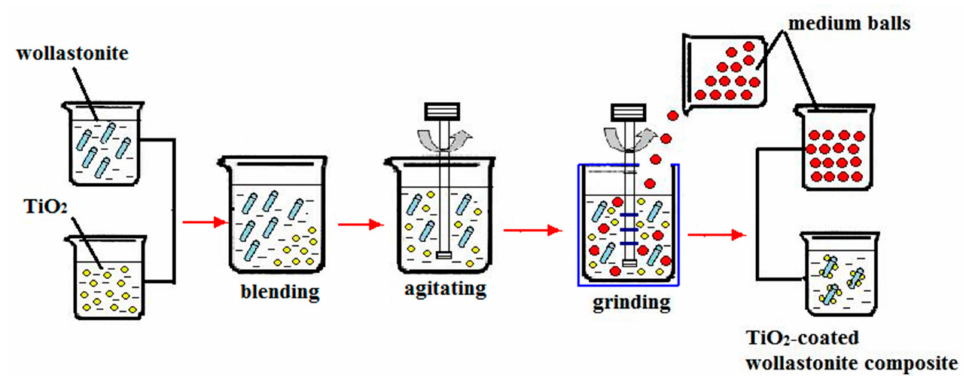
Figure 1. The flow chart for the preparation of TiO 2 -coated wollastonite